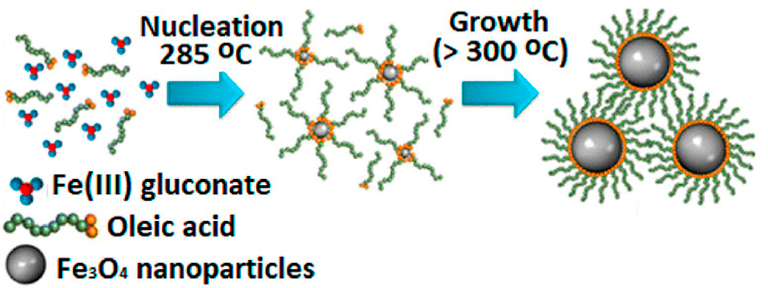
Figure 5. An example of the thermal decomposition of iron(III) gluconate to synthesize superparam- agnetic Fe 3 O 4 nanoparticles [57]. Reprinted (adapted) with permission from Patsula et al.